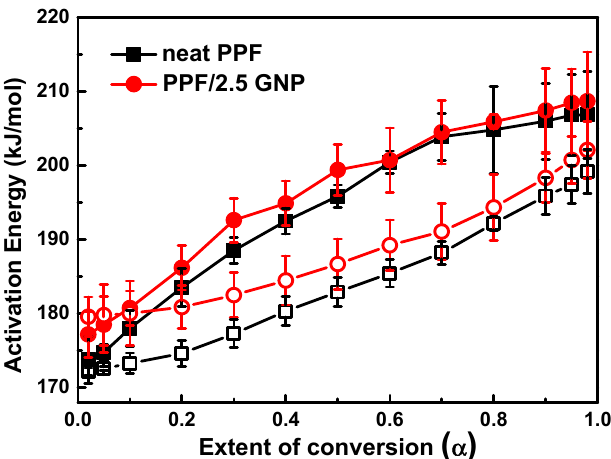
Figure 5. The dependence of activation energy (E) on the extent of conversion ( α ) for the thermal degradation of neat PPF and PPF / 2.5GNP nanocomposite as calculated by Friedman method (filled symbols), and Ozawa Flynn Wall analysis (open symbols).